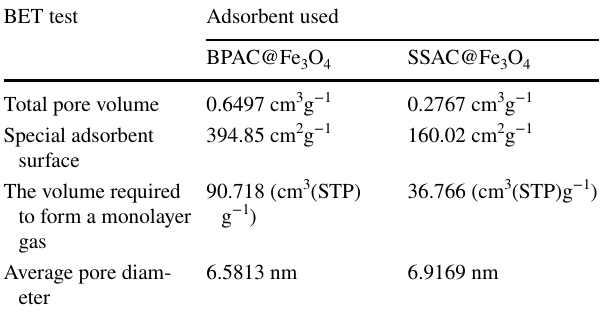
Fig. 3 Scanning electron micrographs (SEM) of SSAC@Fe Table 1 BET analysis data for the adsorbent investigated in this